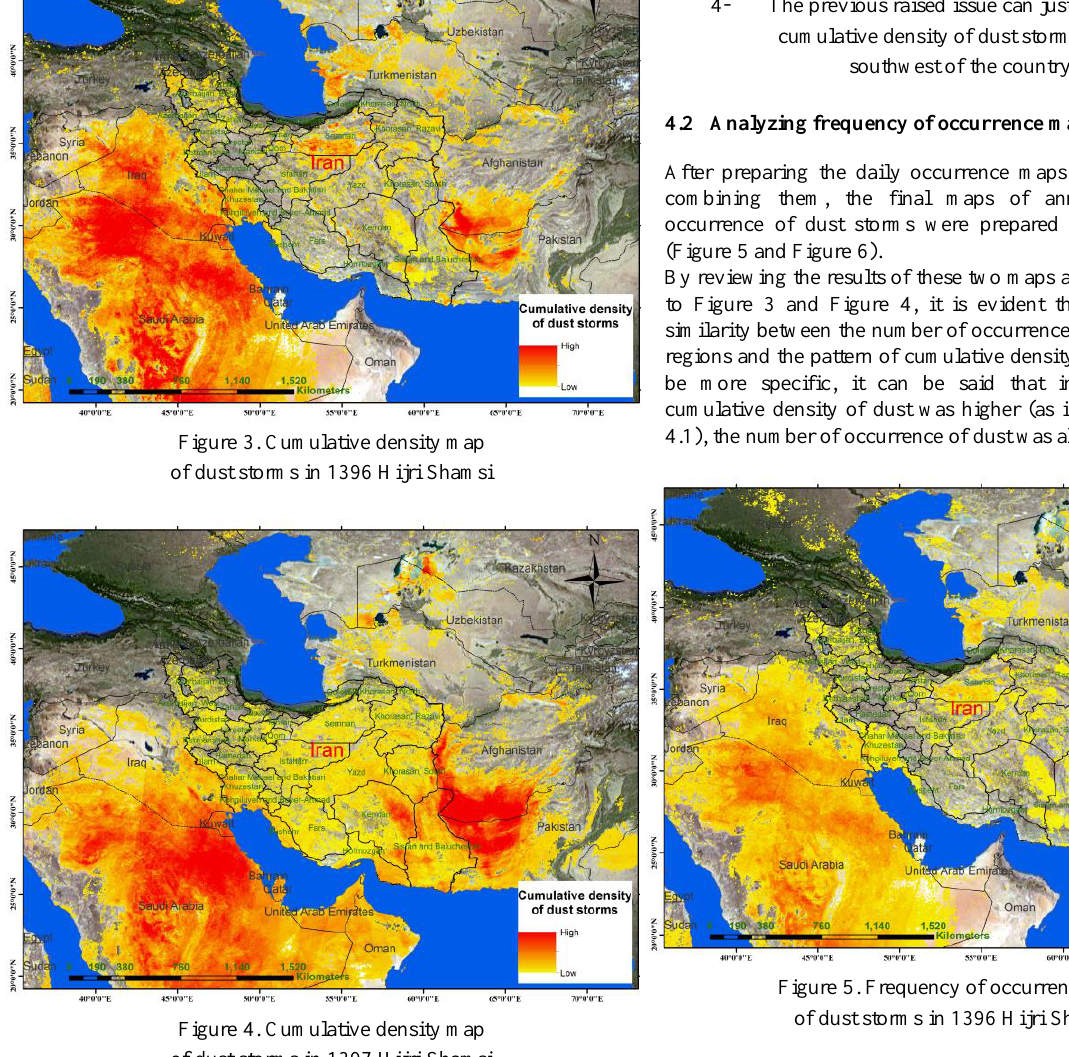
Figure 4. Cumulative density map